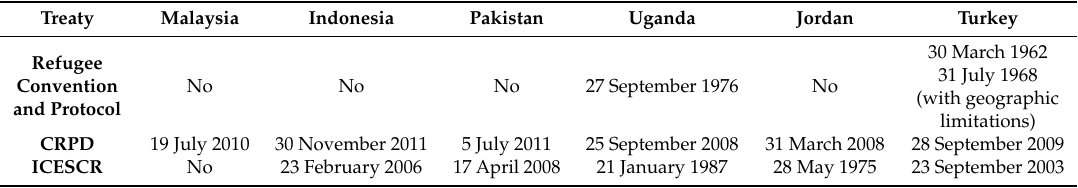
Table 2. Human rights treaties and membership of case study countries (date of accession / ratification).